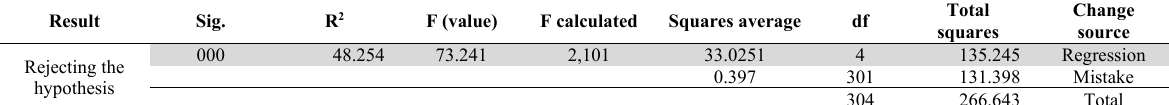
Results of the simple and multiple regression test for the effect of independent study variables on achieving customers' value in travel & tourism organizations in Al-Kharj Governorate.